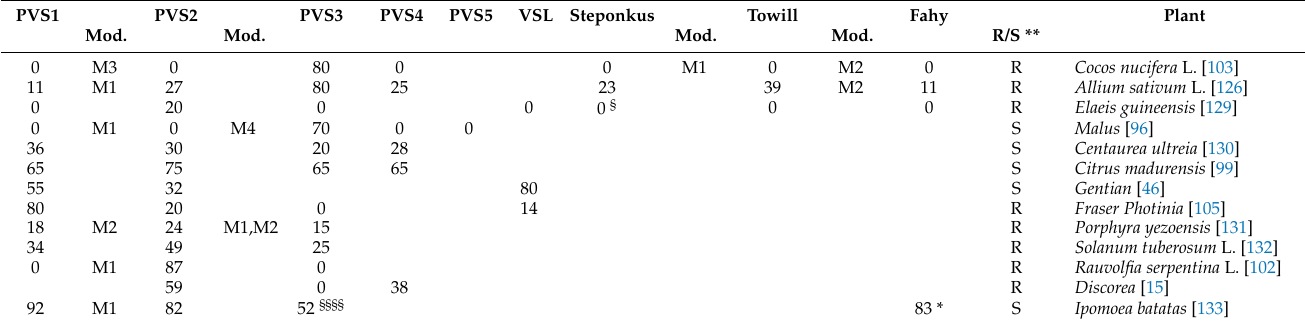
Table 6. Regeneration rate (%) after application of Plant Vitrification Solutions and their modifications (M1_M4 for details see Tables 2–5). Three or more Plant Vitrification Solutions or their modifications at one particular